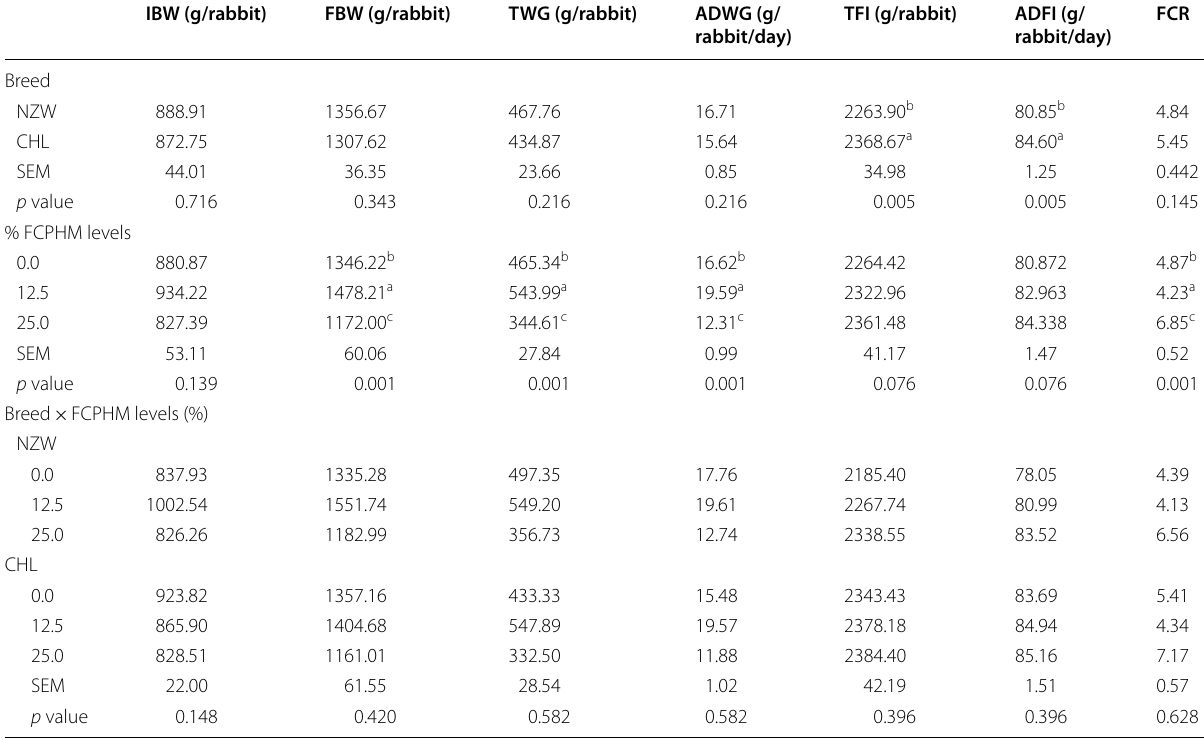
Table 3 Growth performance of New Zealand White and Chinchilla rabbits fed varied levels of FCPHM from 5 to 8th